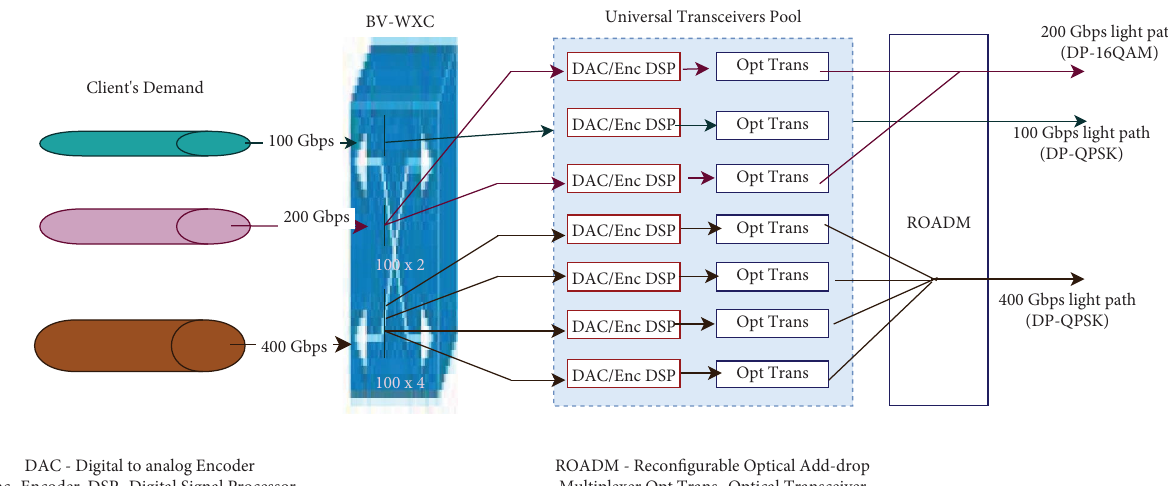
Figure 4: Network architecture for hitless